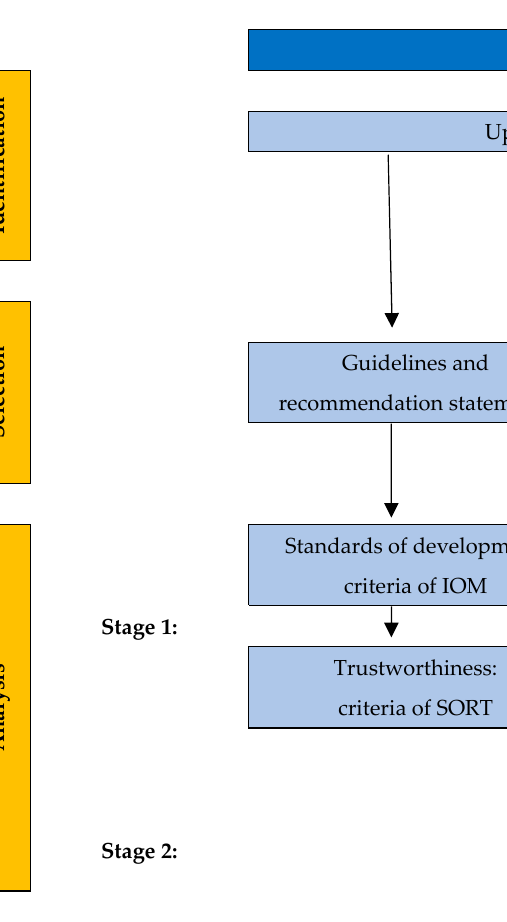
Scheme 1. Steps of the study and reporting of the results. IOM—Institutes of Medicine; SORT—Strength of Recommendation Taxonomy.